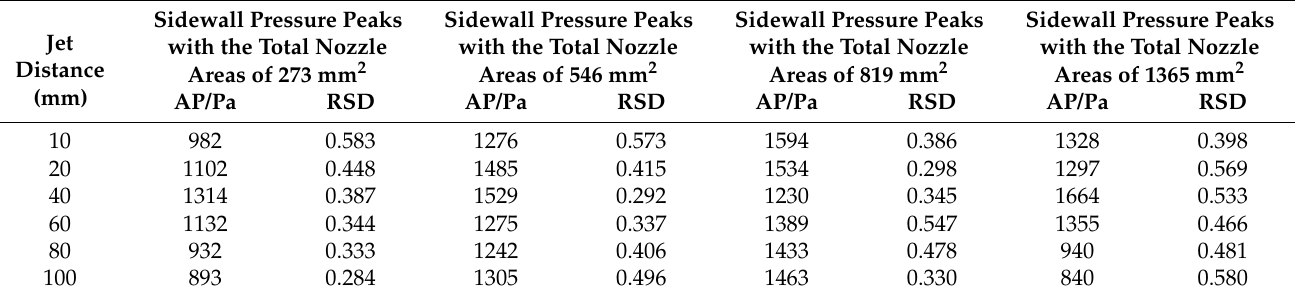
Table 2. The average pressure and relative standard deviation of pressure at the total nozzle areas of different nozzles.